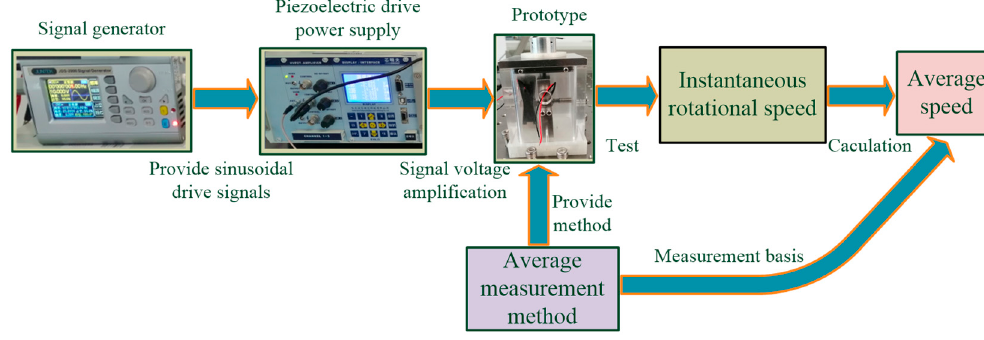
Figure 14. Rotational speed test scheme of the proposed piezoelectric actuator.